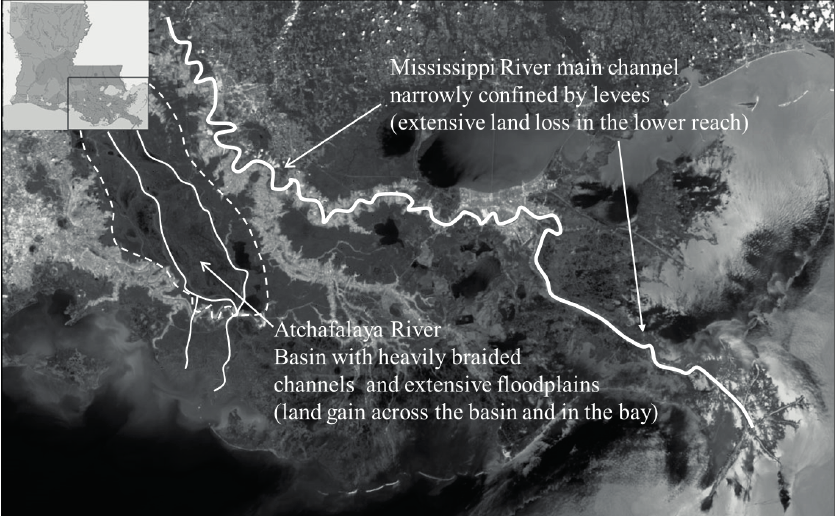
Fig. 3 Extensive land loss in the lower Mississippi River Delta and, in contrast, land gain in the Atchafalaya distributary basin and bay areas.